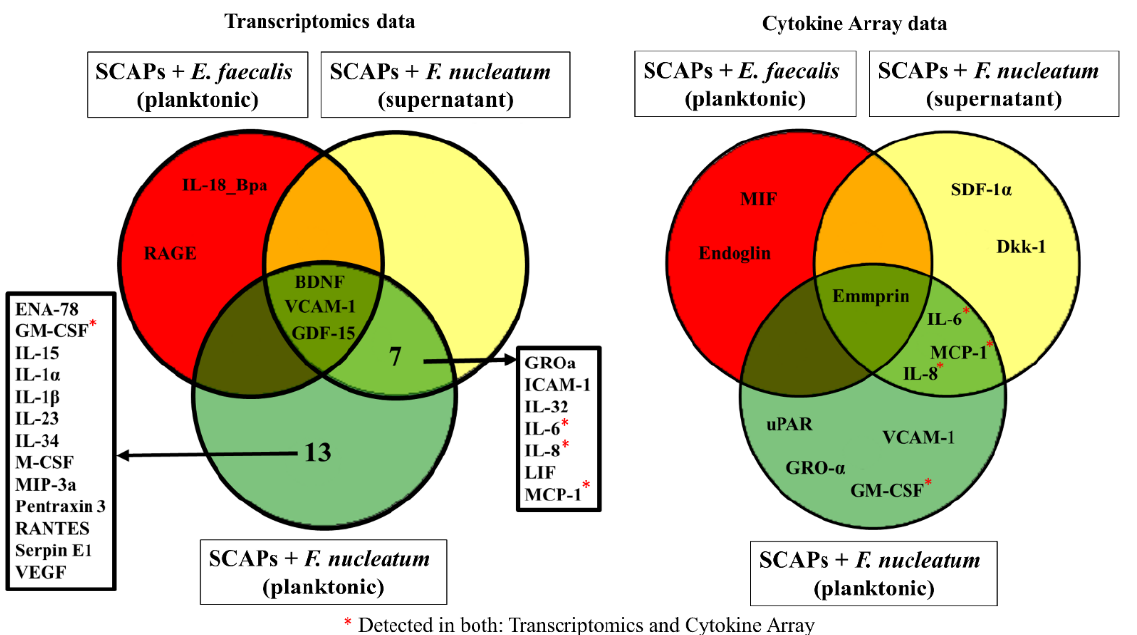
Figure 5. Venn diagrams showing upregulated chemokines and cytokines commonly expressed at mRNA and protein levels. The diagrams show the cytokine secretion at mRNA (on the left) and protein levels (on the right) by SCAP modulated by oral bacteria with different variants of treatment compared with corresponding control levels.